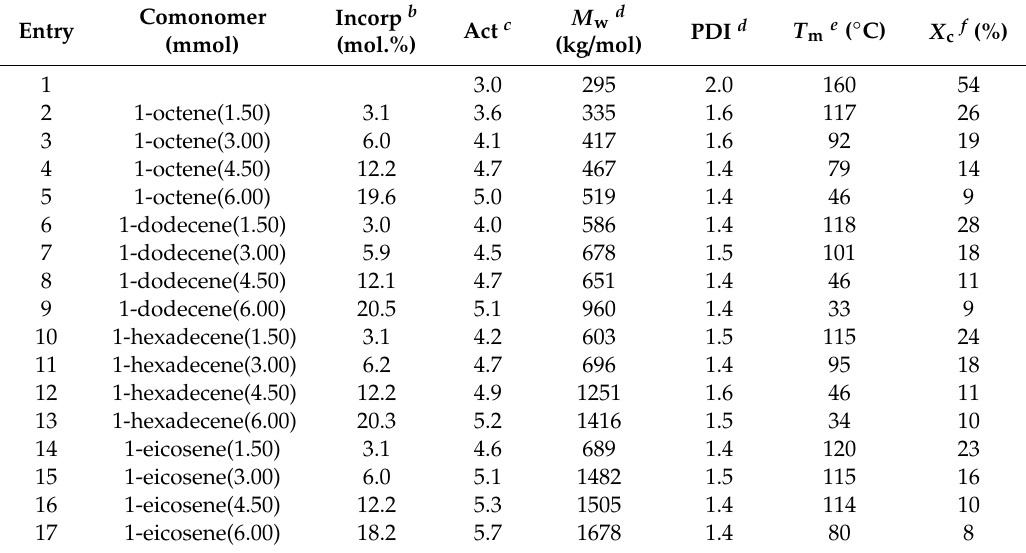
Table 1. The data of copolymerization of propylene with higher α -olefins